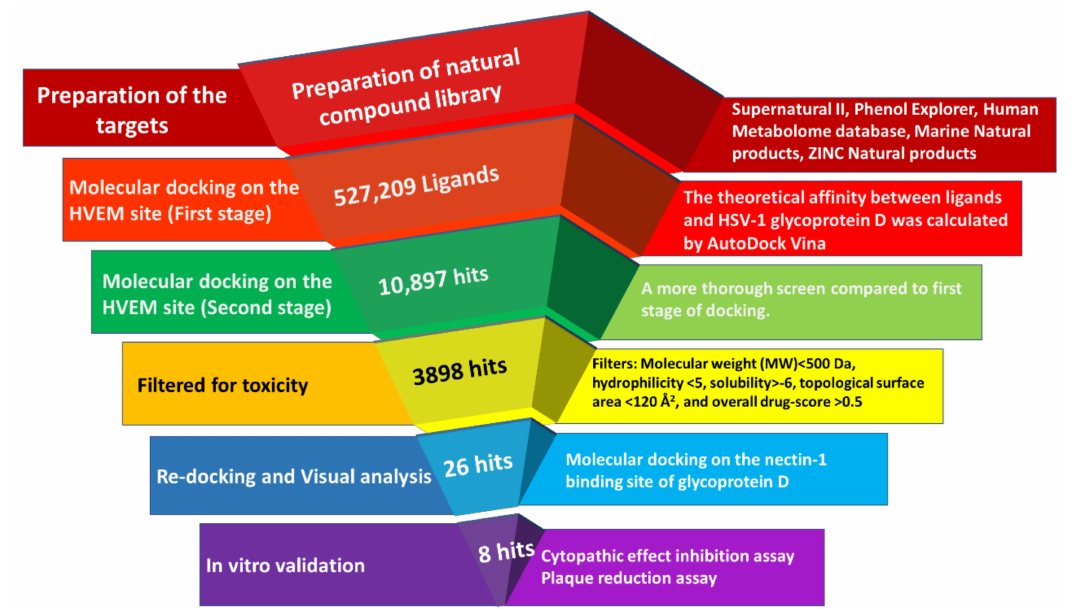
Figure 1. Schematic diagram of the molecular docking workflow for identifying natural glycoprotein D inhibitors with antiviral activity against